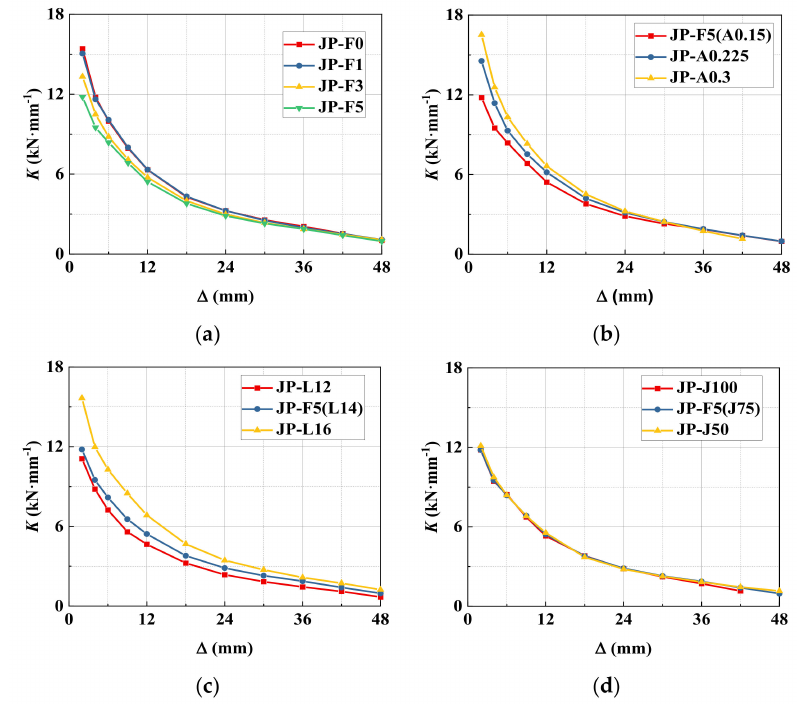
Figure 32. Stiffness degeneration. ( a ) The number of freeze–thaw cycles. ( b ) The ratio of axial compression. ( c ) Diameter of longitudinal reinforcement. ( d ) Stirrup